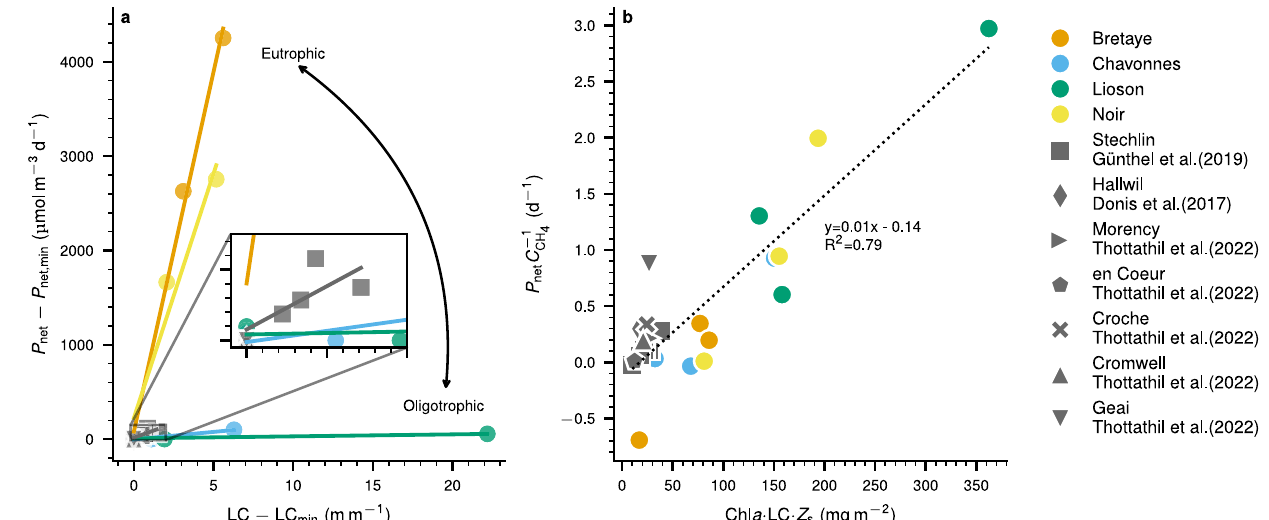
Fig. 5 | Linking netCH 4 production ( P net ) in the surface mixed layer (SML) with trophic variables. a Relationship between P net and light climate (LC, mm − 1 ) and trophic state. Per lake, the minimum P net rate ( P net,min ) and the minimum LC (LC min ) were subtracted to be able to compare the slope of each curve. P net becomes more independent of LC in more oligotrophic lakes. b Interaction between P net (mmol m − 3 d − 1 ) and the average surface concentration of chlor- ophyll- a (Chl a, mgm − 3 ), LC (mm − 1 ) and Secchi depth ( Z s , m) suggest a direct role